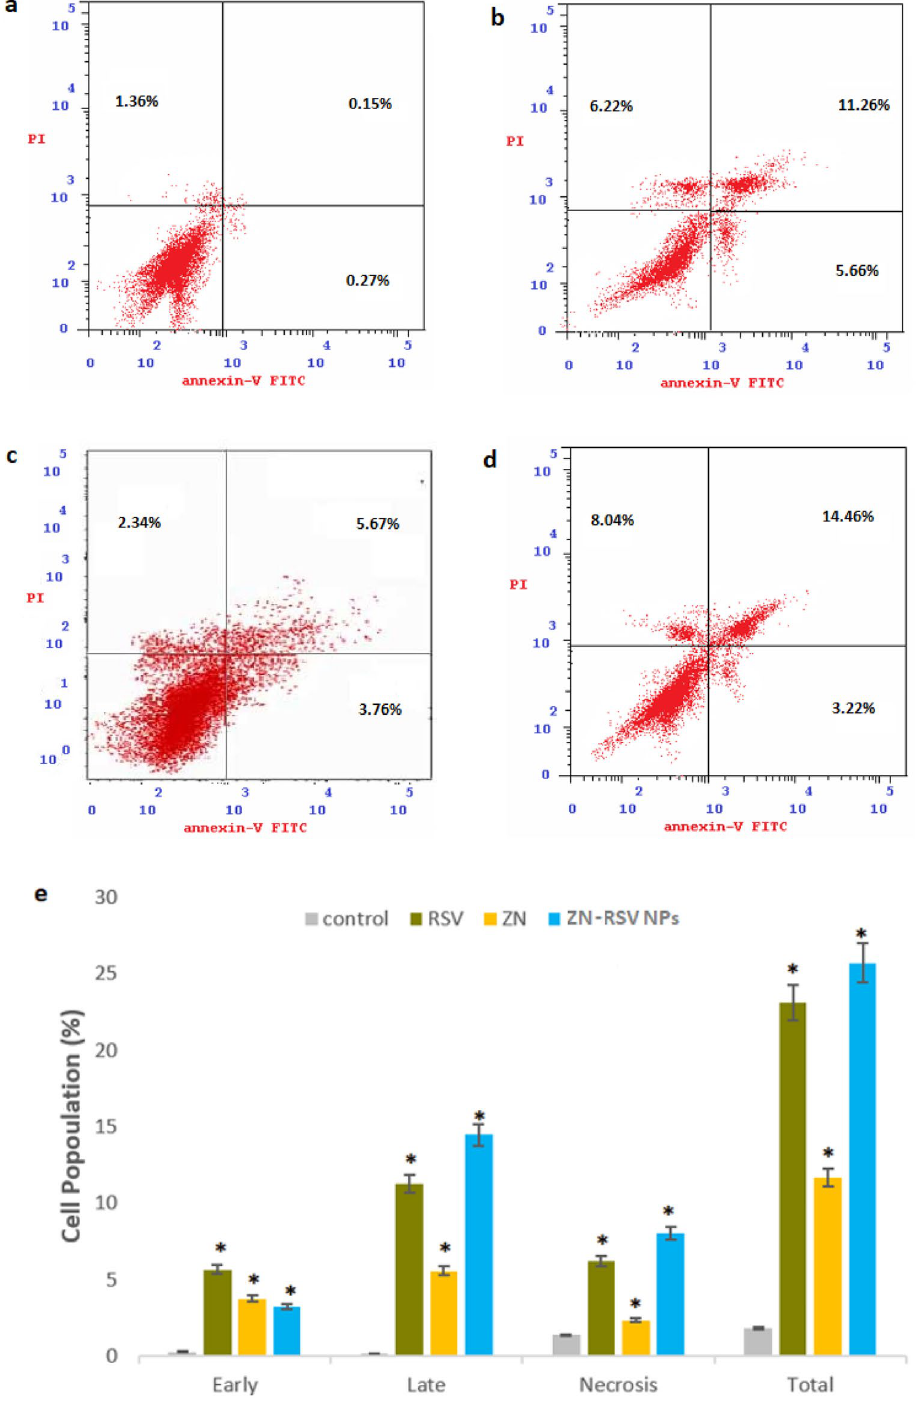
Figure 7. Impact of ZN-RSV NPs on annexin-V FITC positive staining HCT-116 cells. ( a ) Control, ( b ) RSV, ( c ) ZN, ( d ) ZN-RSV NPs, ( e ) graphical presentation of early and late apoptotic, necrotic and total cell death. *Significantly different in comparison with corresponding control group at p <